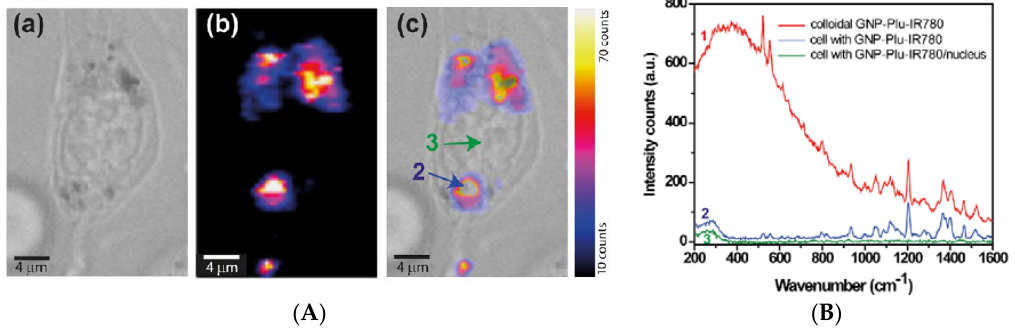
Figure 3. ( A ) bright field image of a C-26 cell incubated with AuNP-Plu-IR780 (a), correspondent SERS map (b) and the overlapping (c) of the two previous images; ( B ) SERS spectra of colloidal solution of AuNP-Plu-IR780 (labelled as 1), and extracted spectra from regions marked blue arrow (2) in image ( A (c)) and from nucleus as marked with the green arrow (3) in ( A (c)). (Reproduced from [79] with permission).